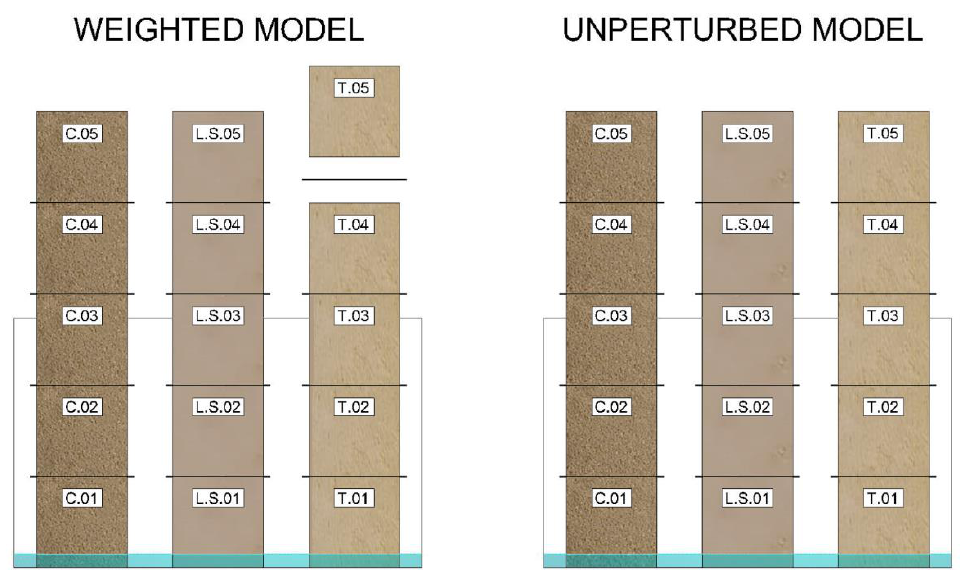
Figure 2. Experimental setup.